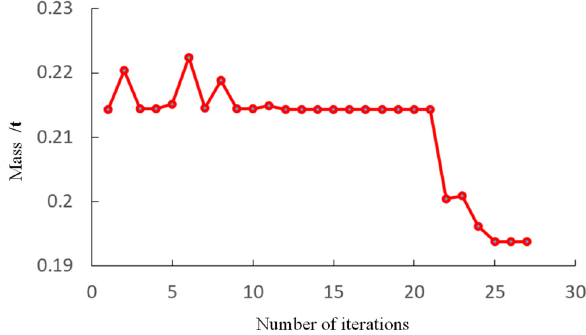
Figure 16: The iteration curve mass